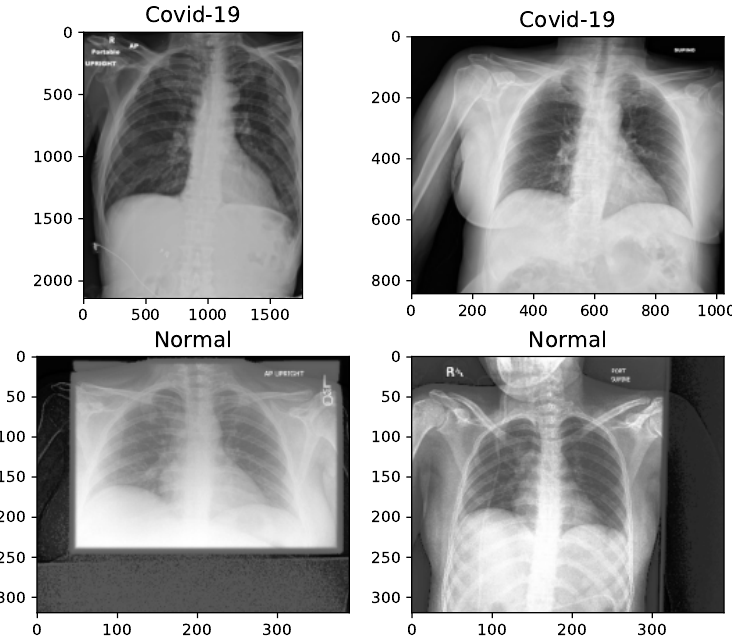
Figure 1. X-ray image samples of two categories before image manipulation.